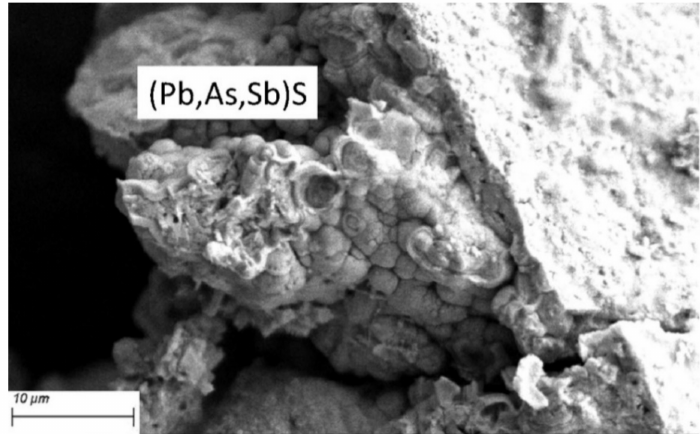
Figure 4. Microscopic photo of (Pb,As,Sb)S scale found at SsF plant [14]. Scales in the range between 150 ◦ C and 65 ◦ C have been sampled in June 2018 before cleaning operation in the ORC evaporator and preheaters after nearly one year of